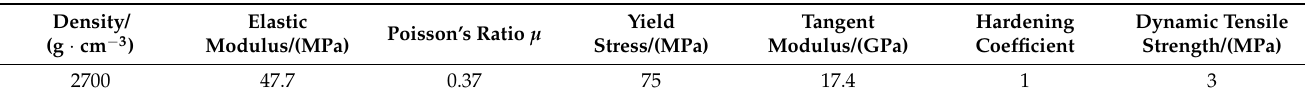
Table 2. Rock mass material parameters.